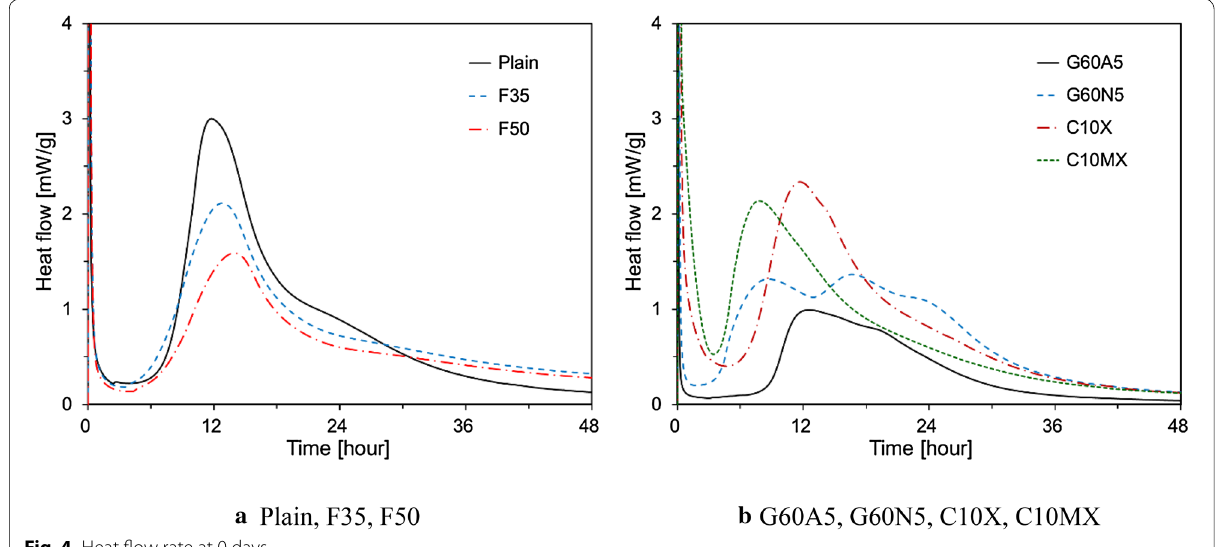
Fig. 4 Heat flow rate at 0